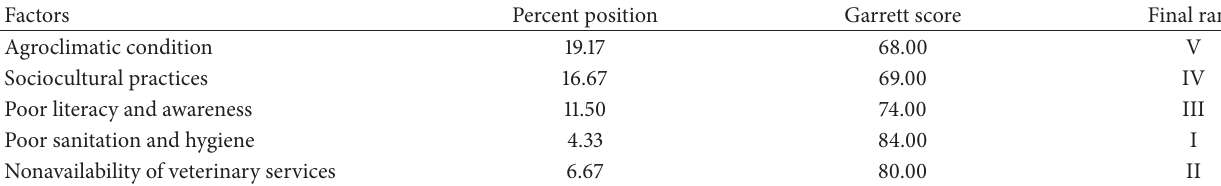
Table 4: Predisposing factors for spread of mastitis in farm